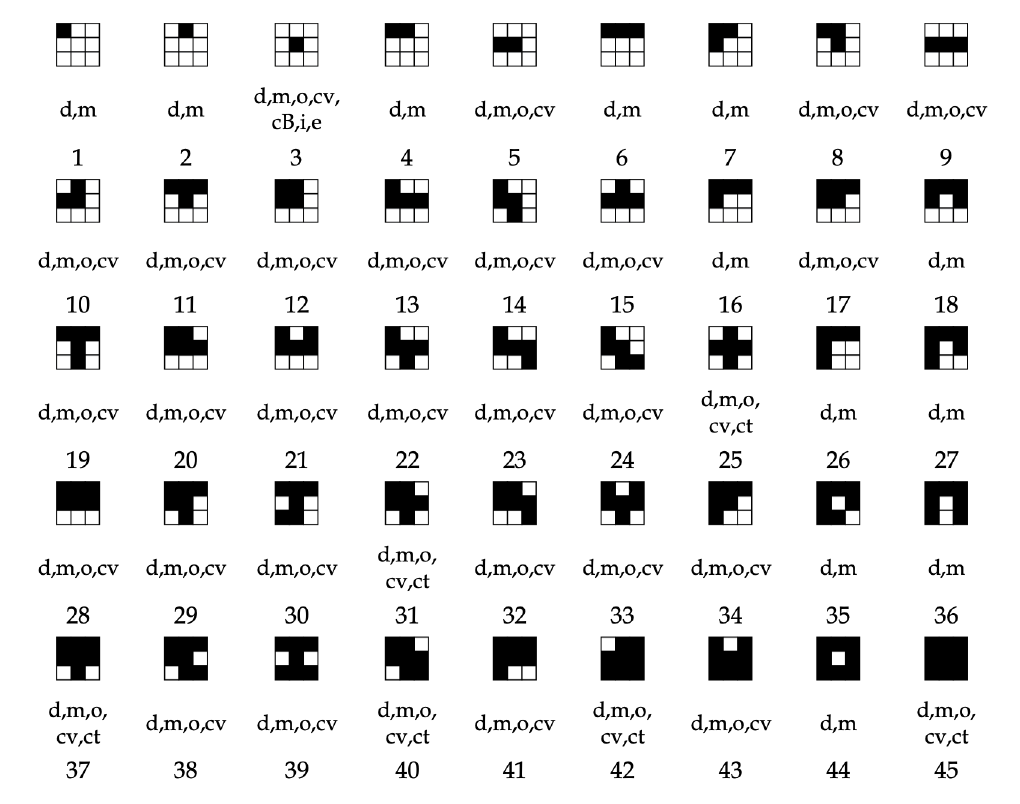
Figure 7: Rules from Guo and Du [23] applied to congruence